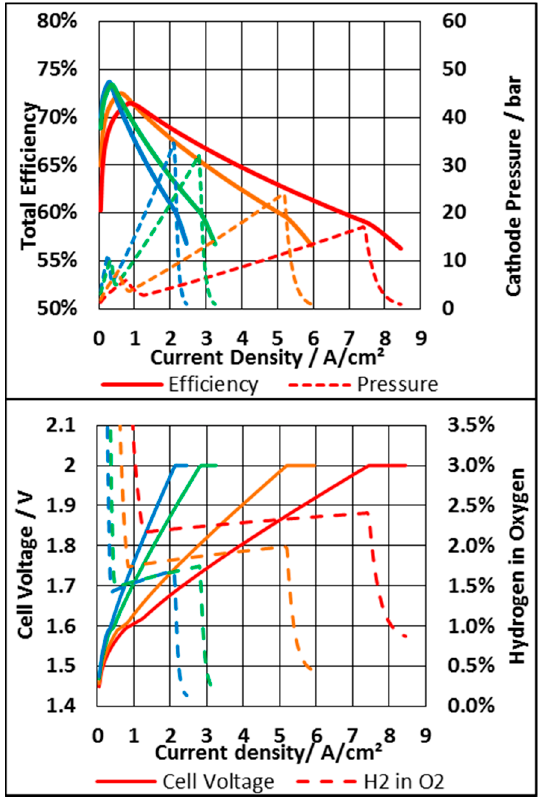
Figure 6. Top : Maximum total efficiency of the PEM electrolyzer as a function of current density by evaluating the optimal cathode pressure for commercial membranes: N211 (red), N212 (orange), N115 (green), N117 (blue). Bottom : Polarization curve and hydrogen in oxygen concentration at the anode.